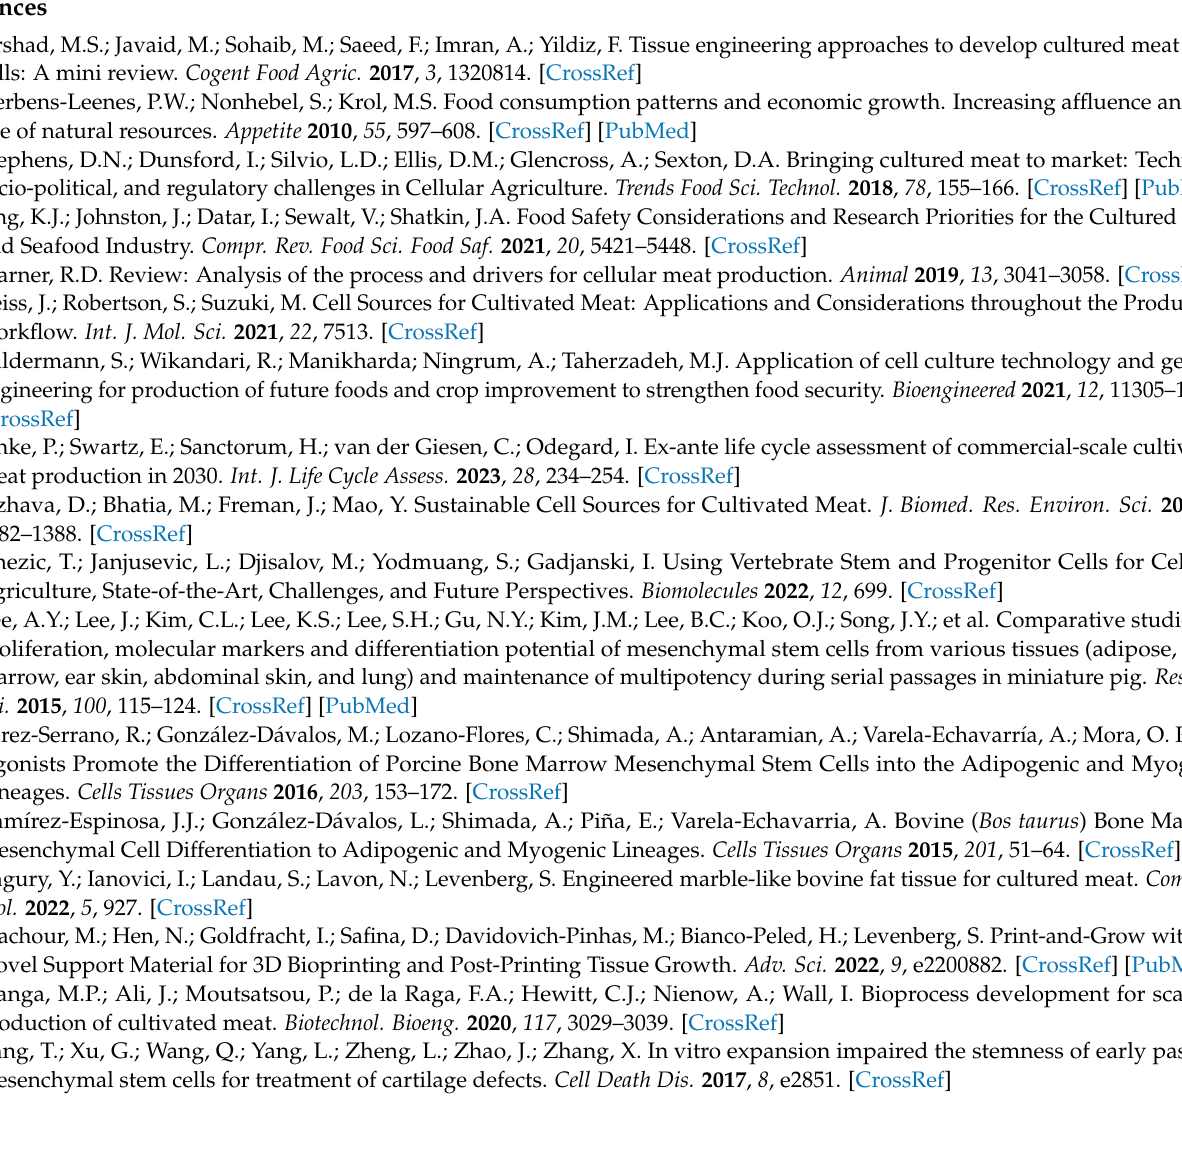
Blots; Figure S2: Original Images of figure 3 for Blots; Figure S3: Original Images of figure 5 for Blots; Figure S4: Original Images of figure 7 for Blots; Figure S5: Original Images of figure 8 for